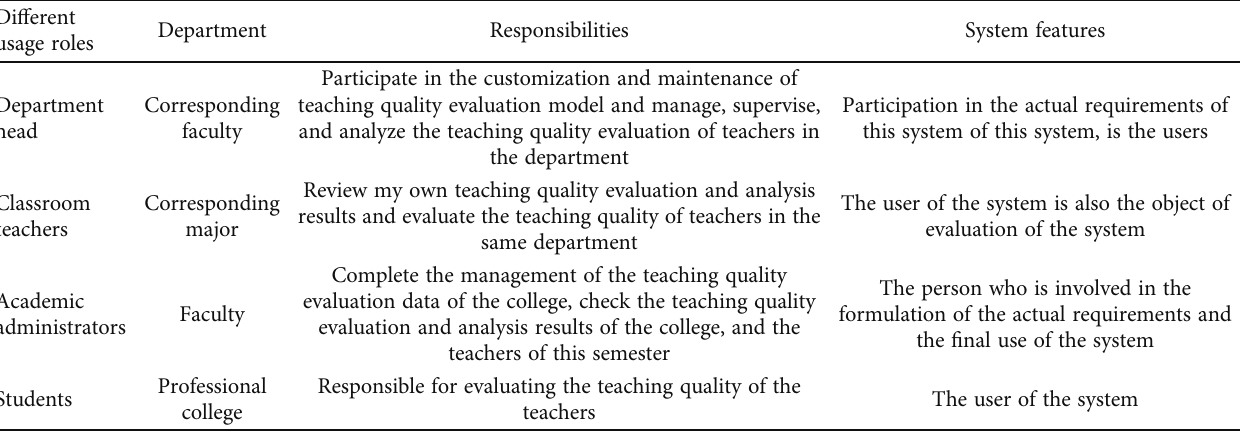
Table 1: Di ff erent user role